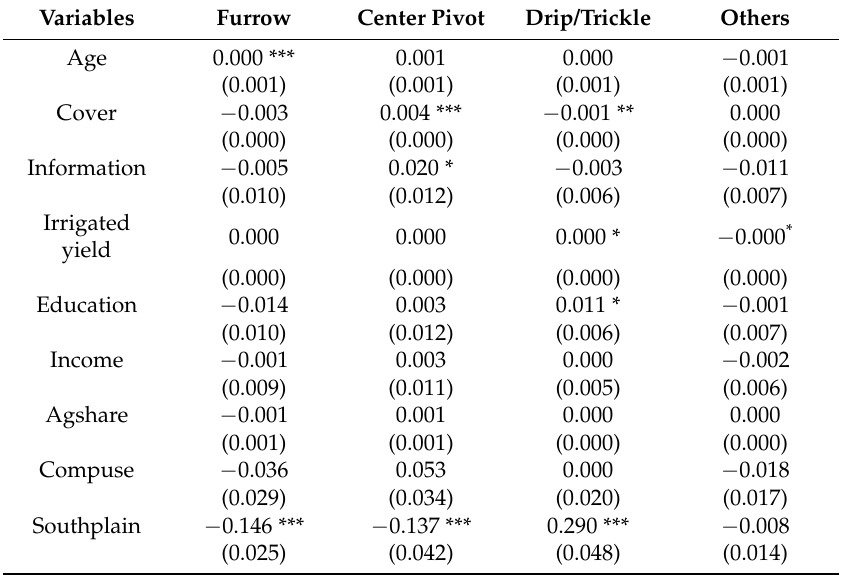
Table 5. Marginal effects of land allocation under alternative irrigation technologies using a multivariate fractional regression